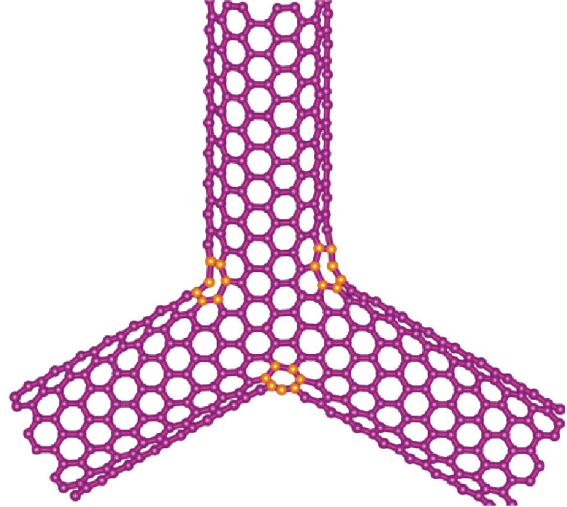
Figure 1: A variant of Y -junction Y Table 1: The ve -degrees of each edge of Y